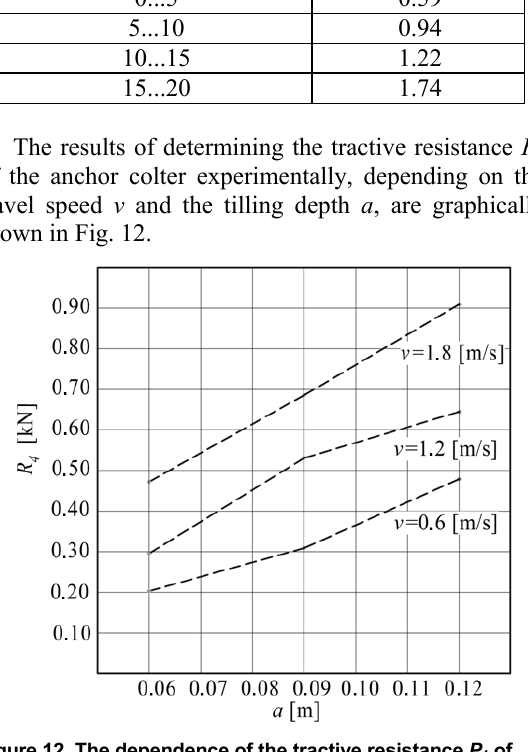
Figure 12. The dependence of the tractive resistance P 4 of the anchor colter on the working speed and the tilling